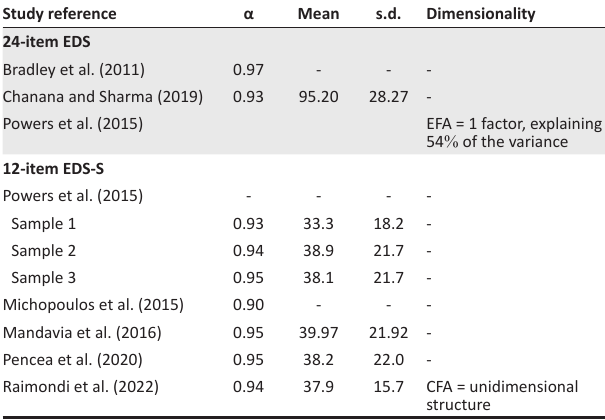
TABLE 1: Summary of published data on the Emotional Dysregulation